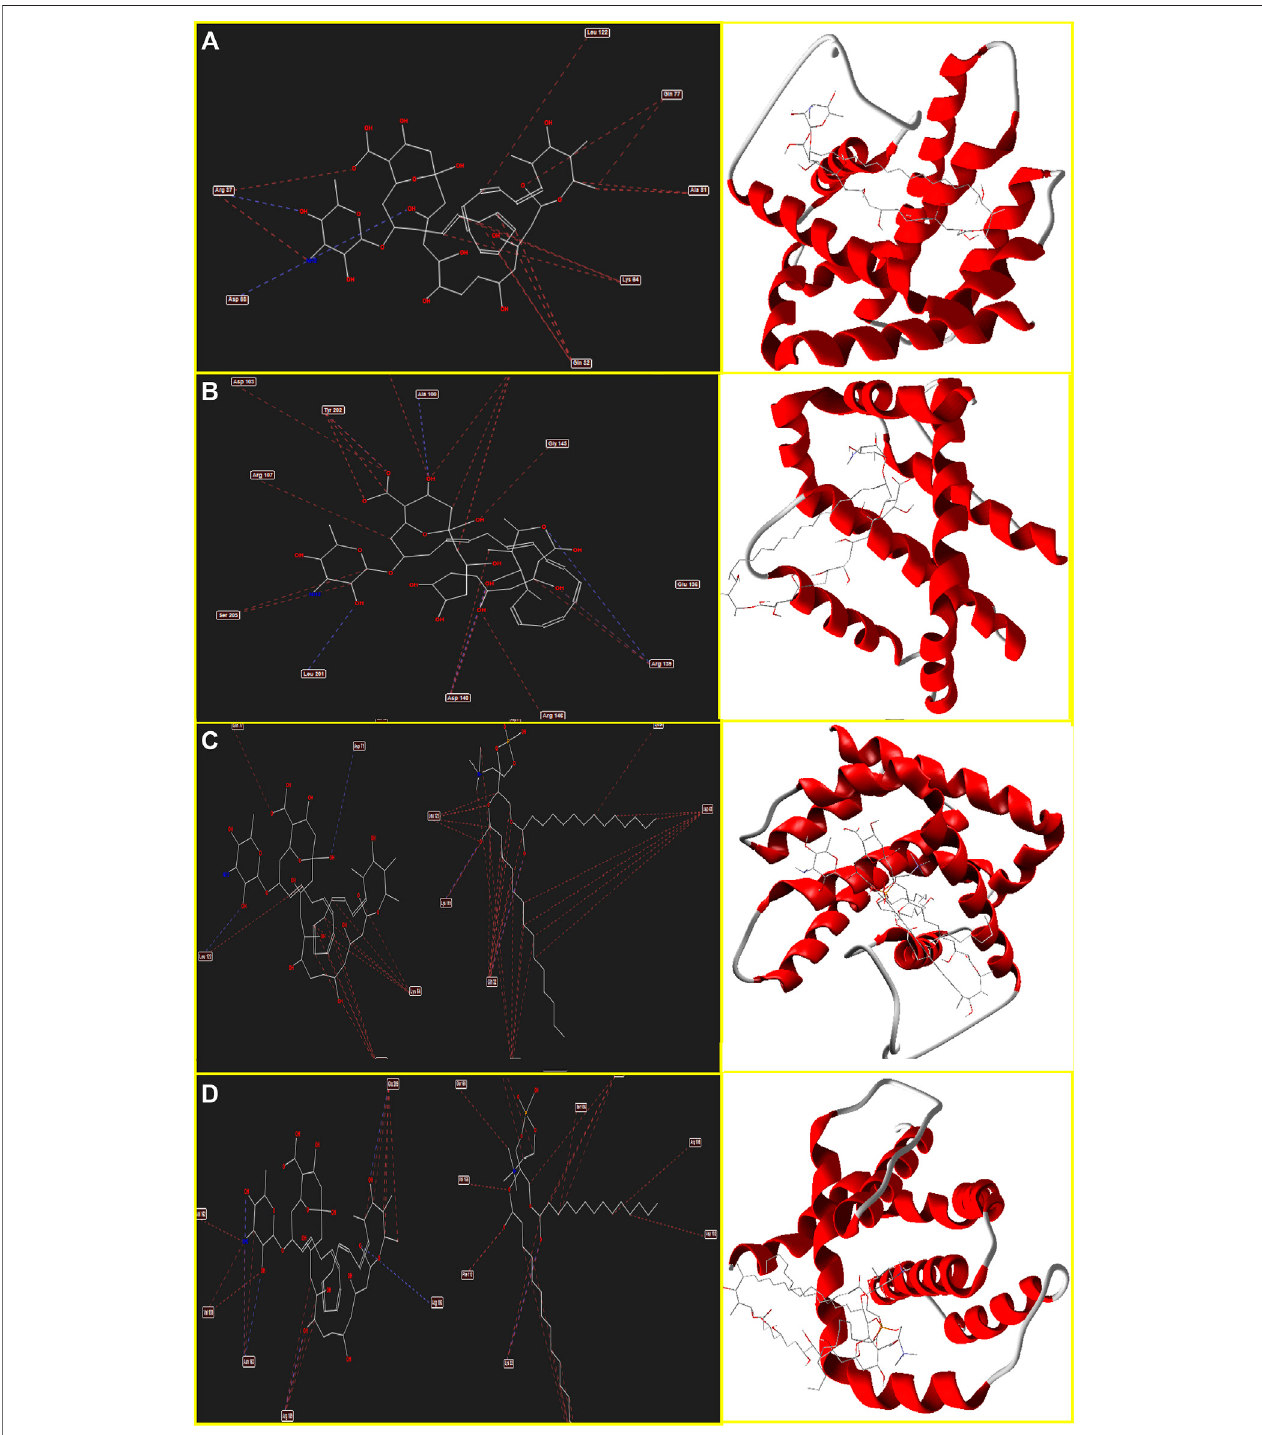
FIGURE3| SchematicofthebestscoredockingsolutionoftheAmpBligandsand (A) BAX, (B) Bcl-2targetandAmBisome, (C) BAXand (D) Bcl-2targetwiththe selected crystal structure of 5W5X and 5JSN, respectively, along with the pharmacophore and ligand map of MMV 7.0.